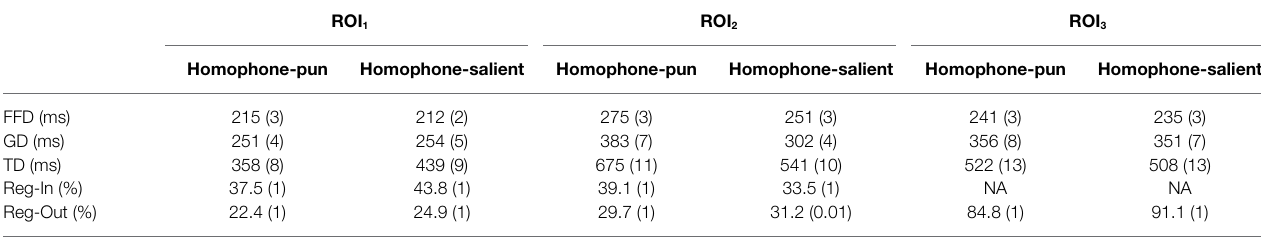
TABLE 3 | Fixation data of different ROIs in homophone-pun and homophone-salient sentences.